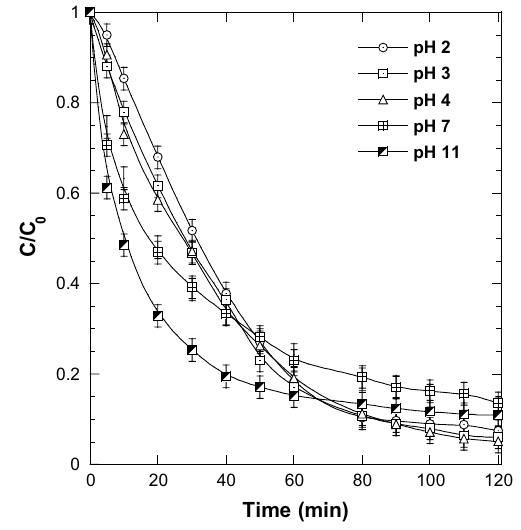
Fig. 8 Degradation kinetics of TB for various initial solution pH (conditions—volume: 100 mL, initial TB concentration: 2 mg/L, tem- perature: 25 ± 2 °C, pH 2–11, frequency: 1700 kHz, power: 15 W)